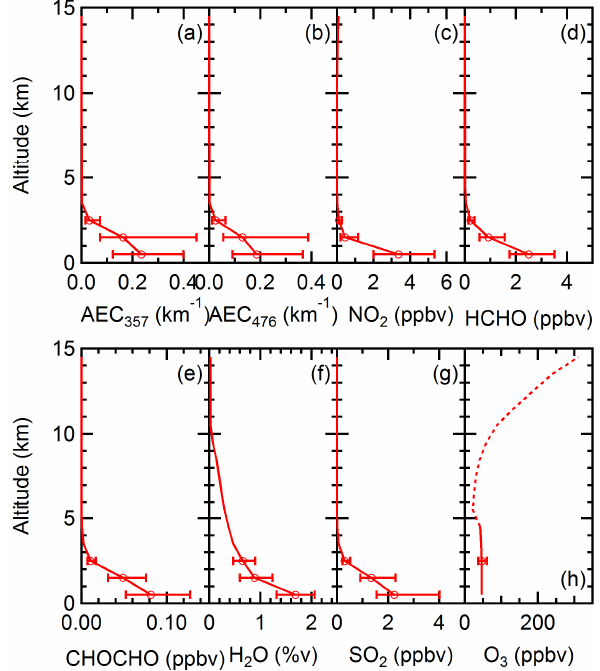
Fig. 2. Median vertical profiles of AECs at 357 and 476nm and NO 2 , HCHO, CHOCHO, H 2 O, SO 2 , and O 3 VMRs retrieved for the CINDI campaign period. Error bars represent the 67%-range. For all species except O 3 , vertical profiles above 3km have been determined mostly by the a priori. For O 3 , two different parame- ters retrieved represent O 3 vertical profiles below (solid curve) and above 5km (dotted curve), respectively (see the text for more de-